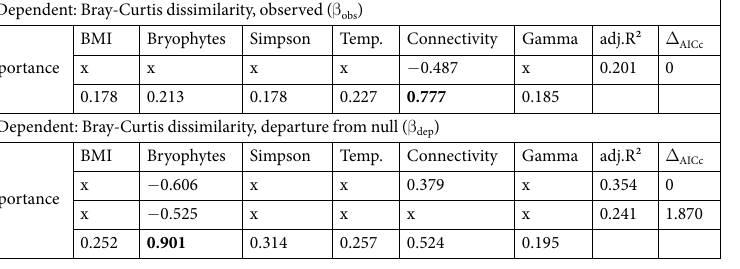
Table 1. Standardized regression coefficients for the best models ( Δ AICc < 2) explaining temporal β diversity in stream macroinvertebrate community composition based on Bray-Curtis dissimilarity values (average dissimilarities between consecutive years) on log(x + 1)-transformed data. Dependent variables are (a) observed dissimilarity ( β obs ) and (b) departure of the observed dissimilarity from the null expectation ( β dep ). x Denotes that a variable was not included in that model. The overall importance across all candidate models is also presented for each predictor; the highest importance value is given in bold. BMI = bed movement intensity, Temp = water